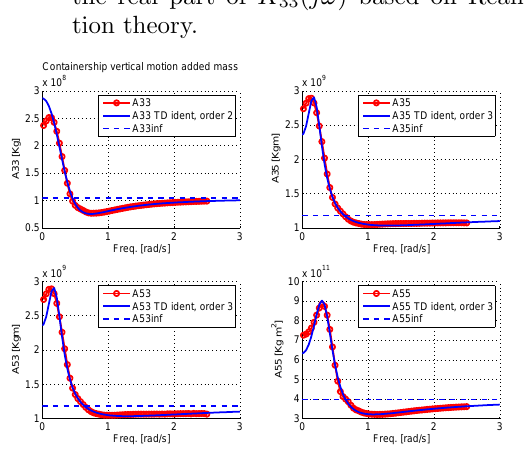
Figure 11: K 33 ( jω ) and ˆ K 33 ( jω ) based on frequency response curve